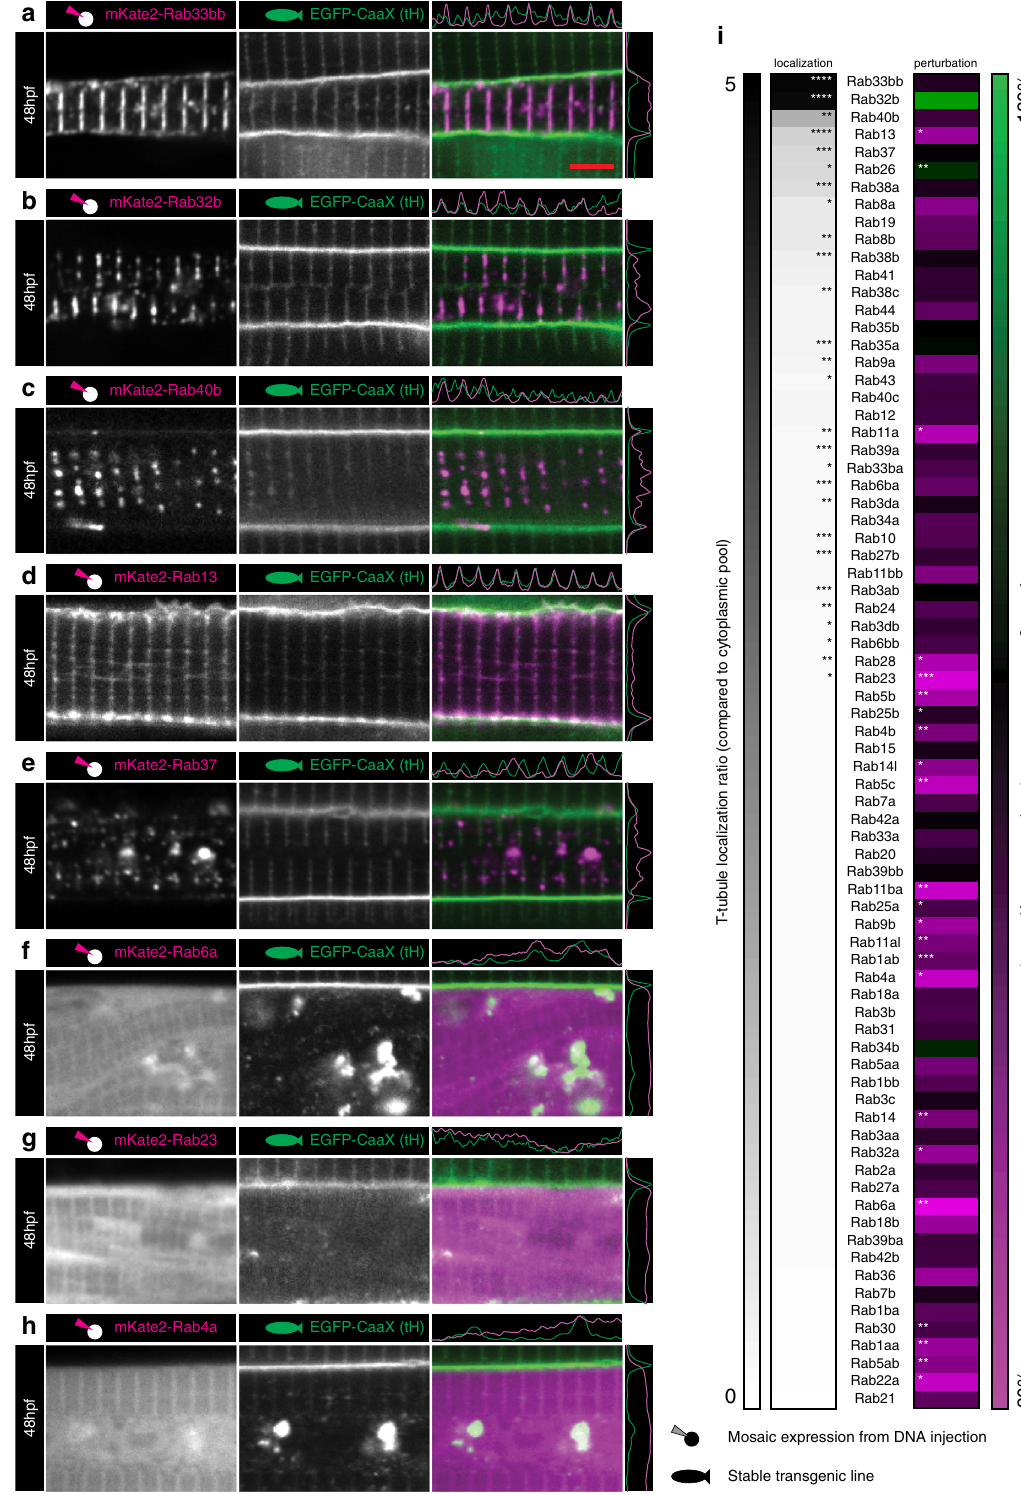
Fig. 8 An overexpression screen of Rab proteins. a – e Top fi ve hits for T-tubule localisation. a Rab33bb. b Rab32b. c Rab40b. d Rab13. e Rab37. f – h Top three hits for perturbation of fl uorescence amplitude. f Rab6a. g Rab23. h Rab4a. i Ranked heatmap showing speci fi c localisation to the T-tubule domain, and the capacity of Rab overexpression to perturb T-tubule formation. n = 6 fi bres per marker, each from individual biologically independent animals per condition, measured over one independent experiment. Two-tailed T-test. * p < 0.05, ** p < 0.01, *** p < 0.001, ****p < 0.0001. Exact p values are given in source data. Scale bars, 5 µ m. See also Supplementary Fig. 8. All images are representative of 12 individual cells within different individual